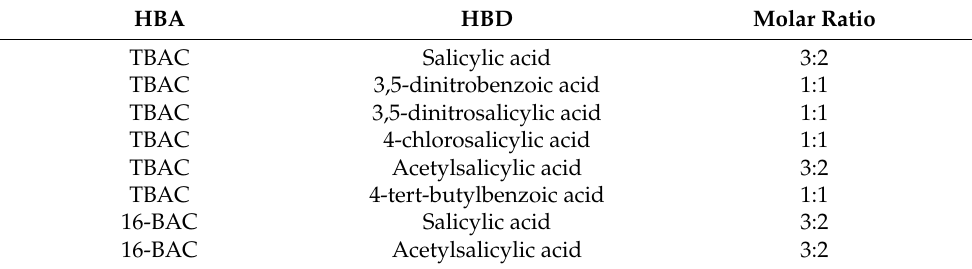
Table 4. Mole ratios of investigated